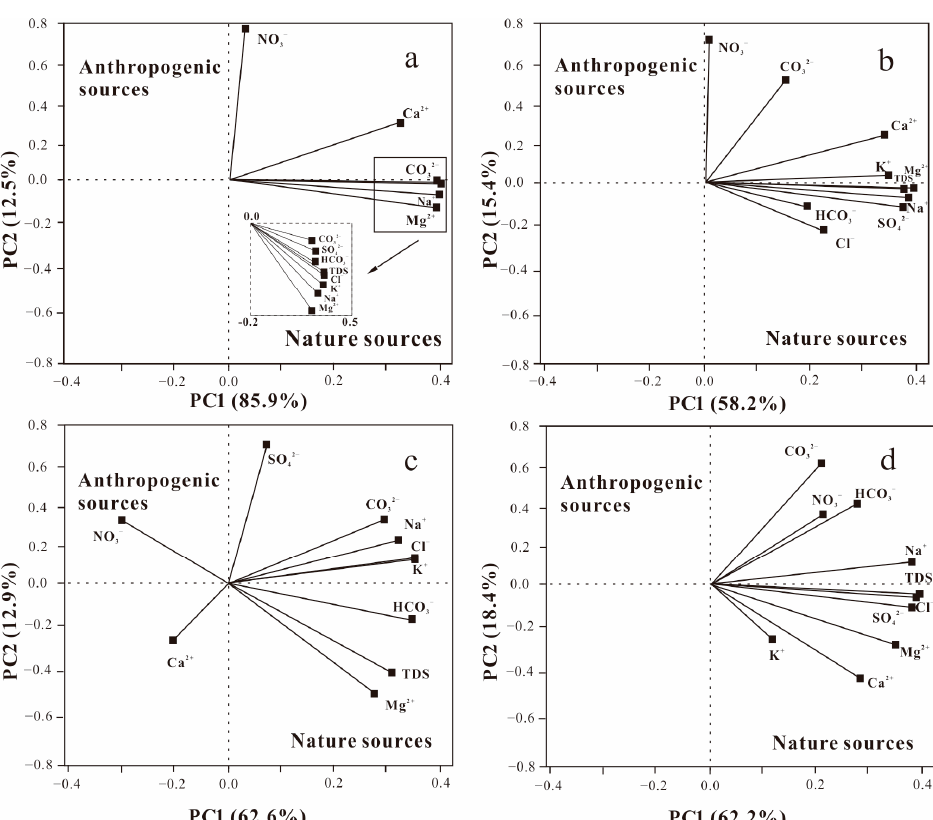
Figure 6. Principal component analysis of the major ions in water bodies in the Hulun Lake Basin in different seasons: ( a ) lake water in the non-frozen season; ( b ) groundwater in the non-frozen season; ( c ) lake water in the frozen season; ( d ) groundwater in the frozen season.